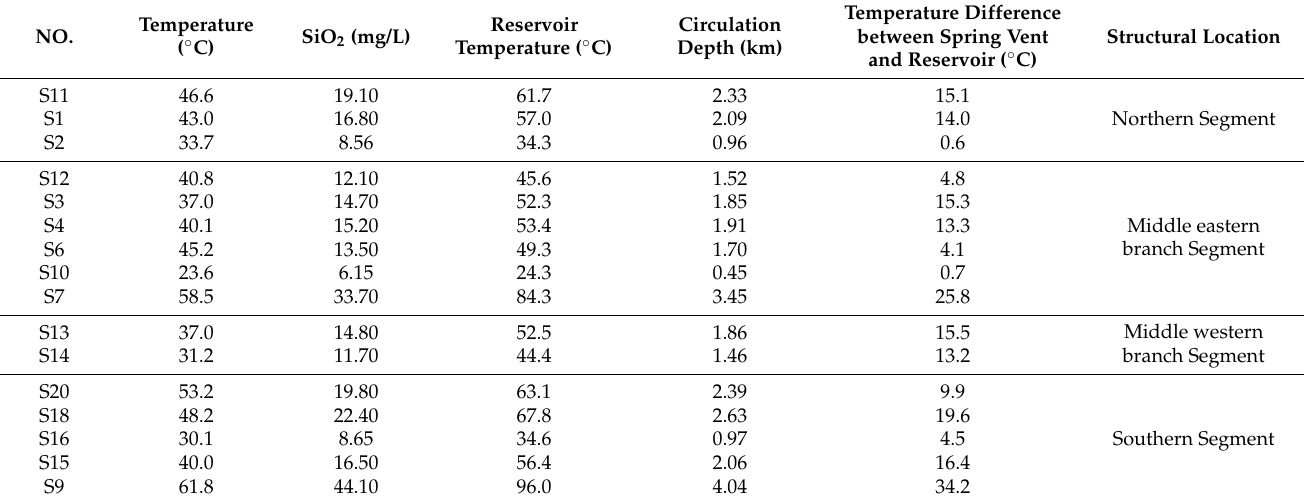
Table 1. Analytical data of reservoir temperature and circulation